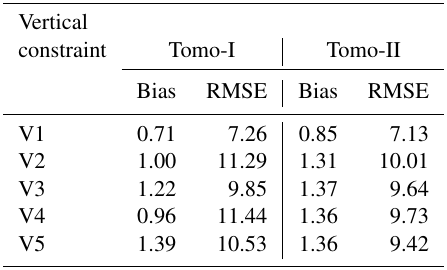
Table 2. Statistics of the differences of wet refractivity between ra- diosonde measurements and tomography (unit: mmkm − 1